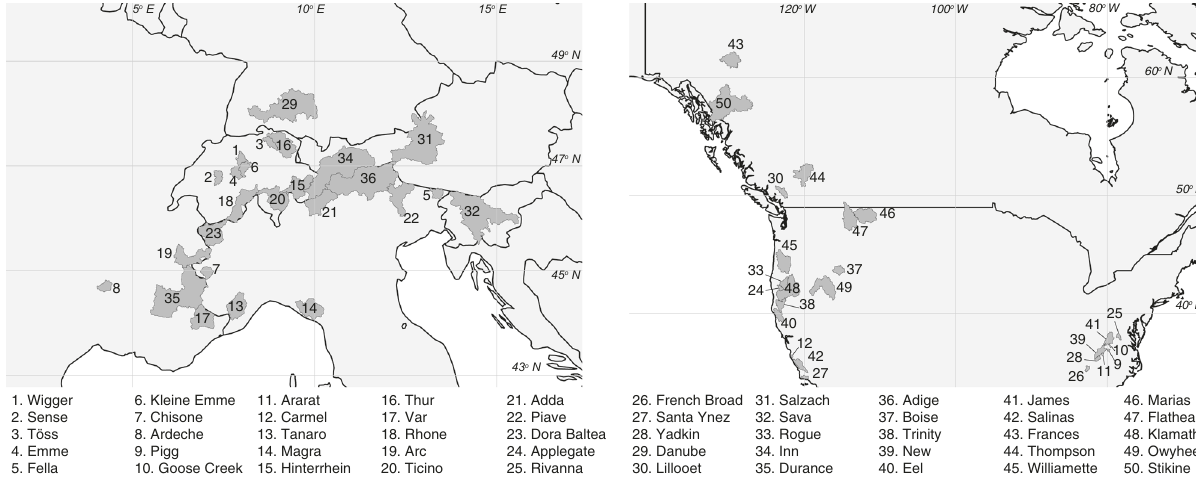
Fig. 4 Location of real river basins used in the analysis. River basins are shown in dark grey; countries in light grey. Rivers' numbering is sorted in ascending order according to drainage area values.